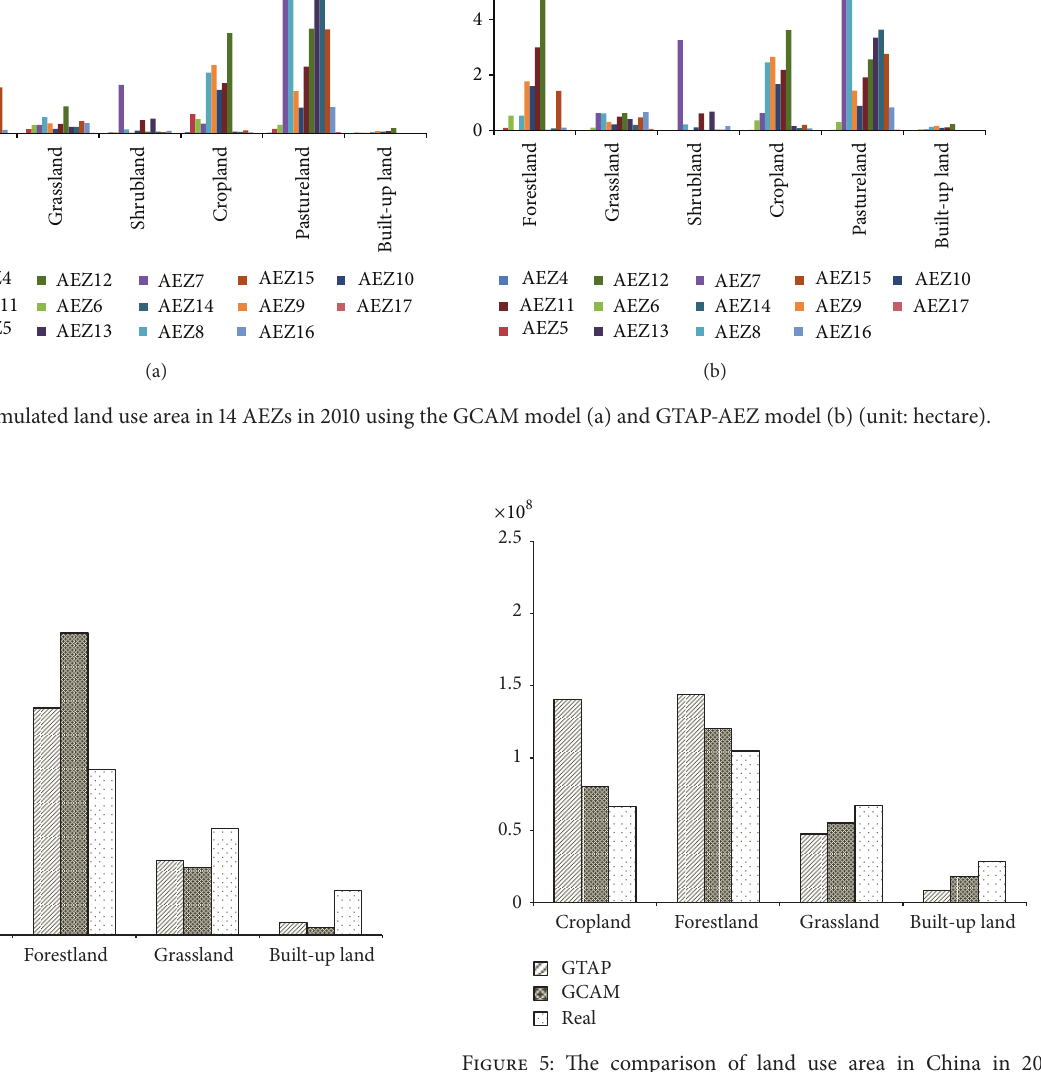
Figure 4: Comparison between the simulated and real land use areas in 2010 (unit: hectare).